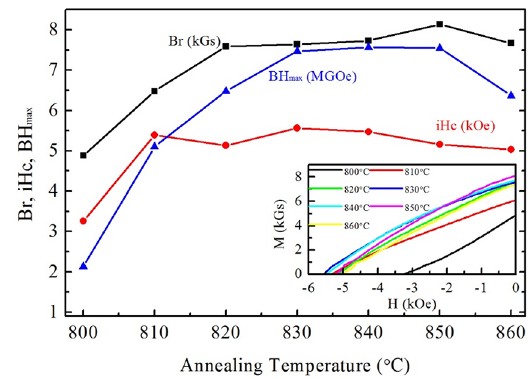
Figure 3. The remanence, coercivity and magnetic energy product for samples annealed at 800, 810, 820, 830, 840, 850, and 860 °C for 10 min under Argon atmosphere. Inset is the corresponding demagnetization curves for all the